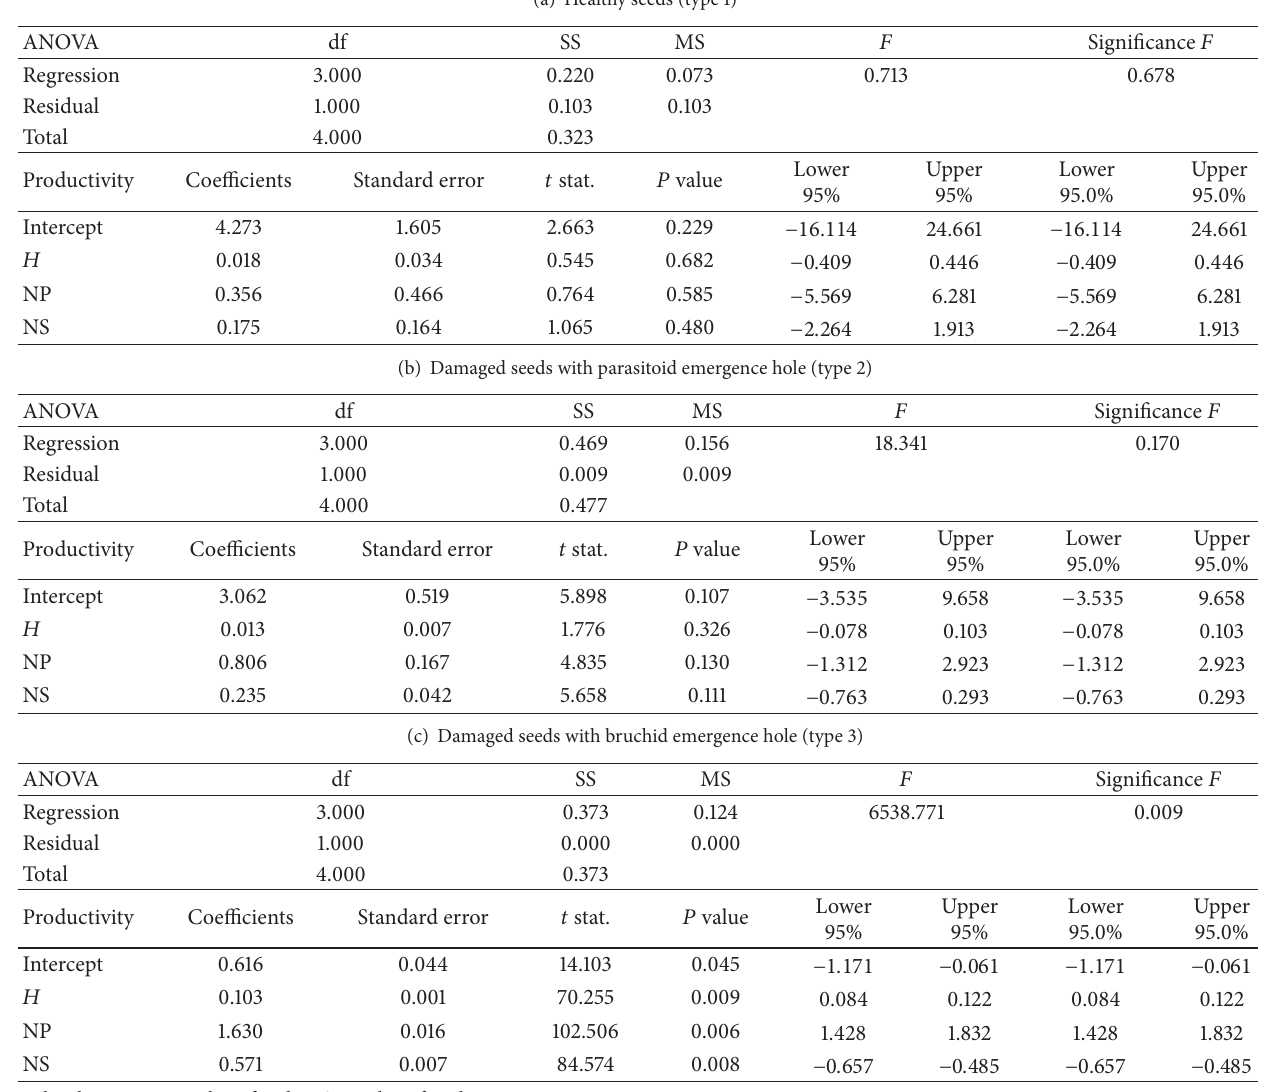
Table 6: Regression coefficients of the pea productivity in regard to the productivity